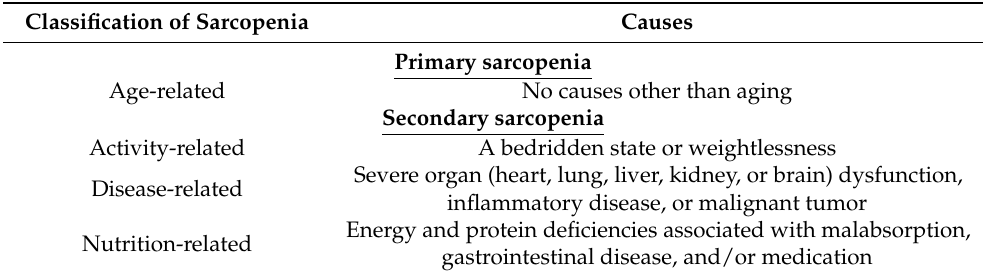
Table 1. Classification of sarcopenia.